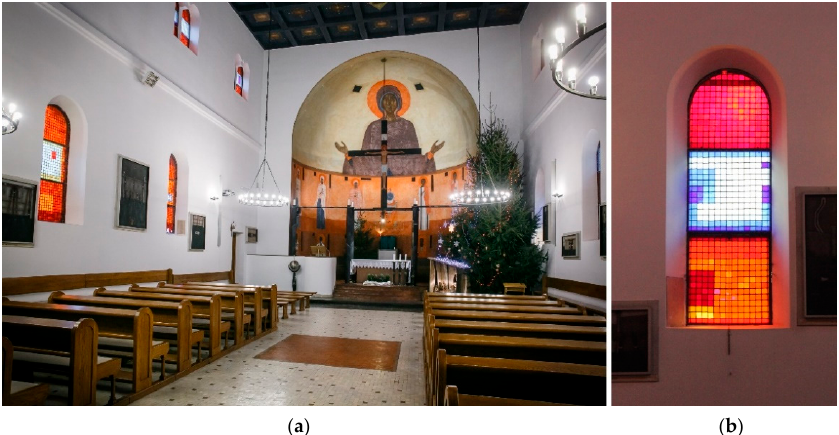
Figure 10. Roman Catholic Church in Wesoła: ( a ) overall view of the interior. Photography by Iwona Bal. ( b ) stained glass window. Photography by the